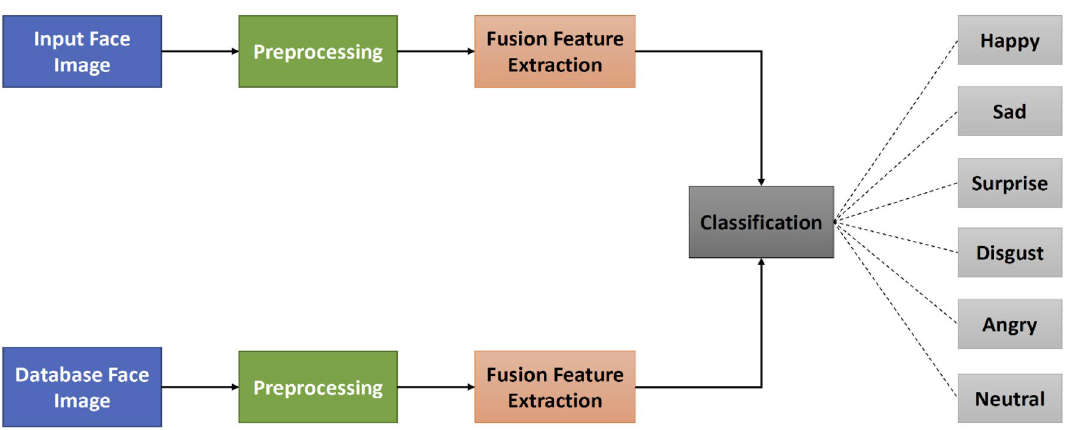
Figure 3. Summary flowchart for the three phases of the Facial Expression Recognition (FER)